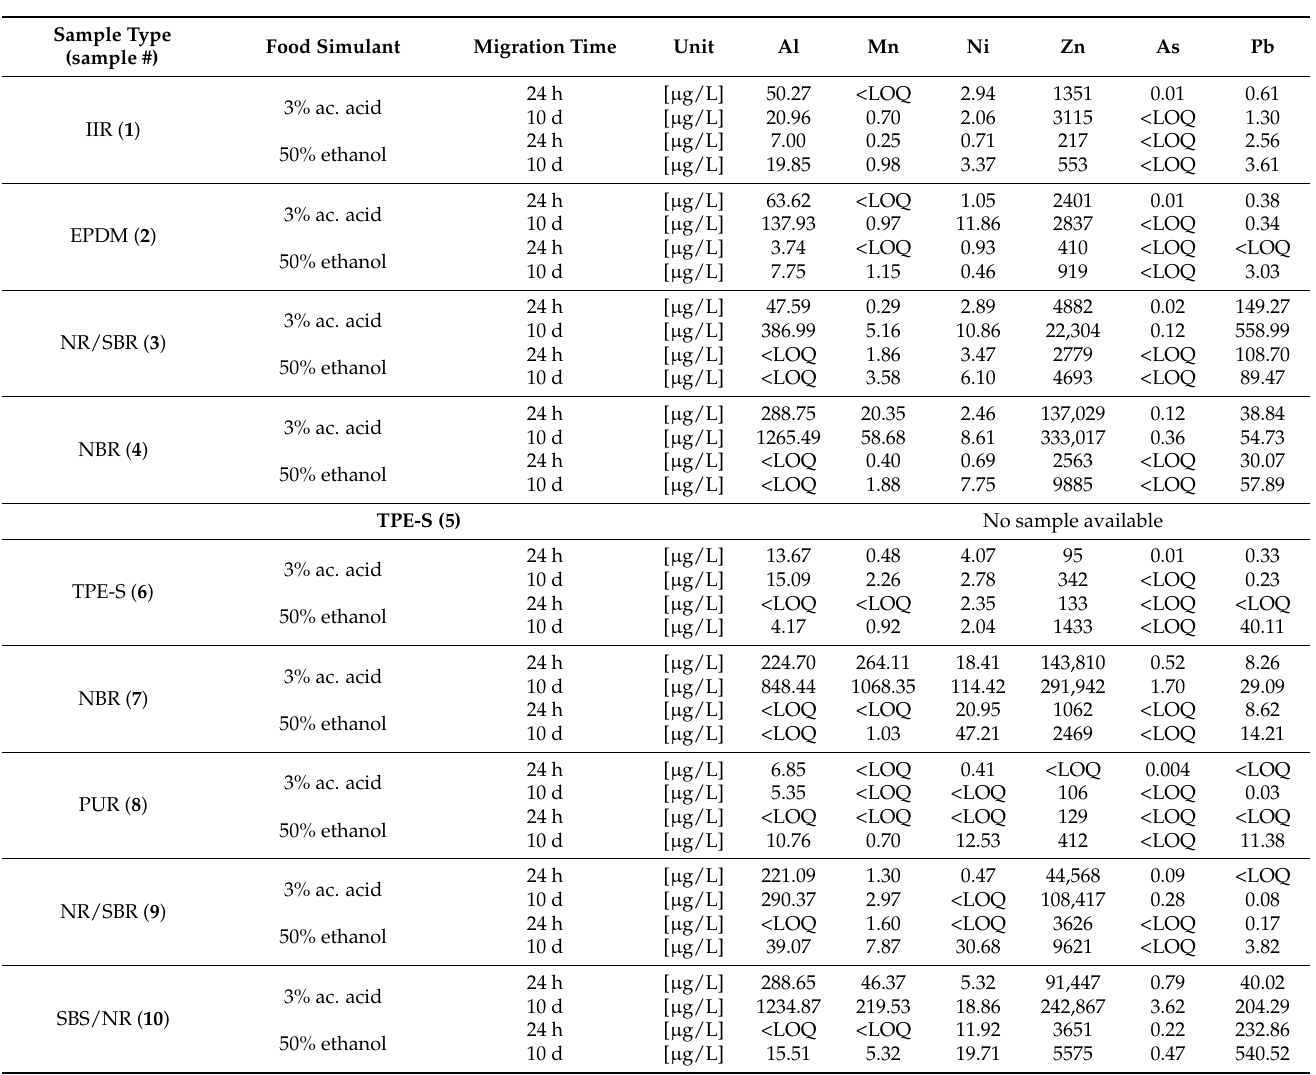
Table 6. Release of selected elements from elastomer samples after 24 h and 10 days of migration time in 3% acetic acid and 50%